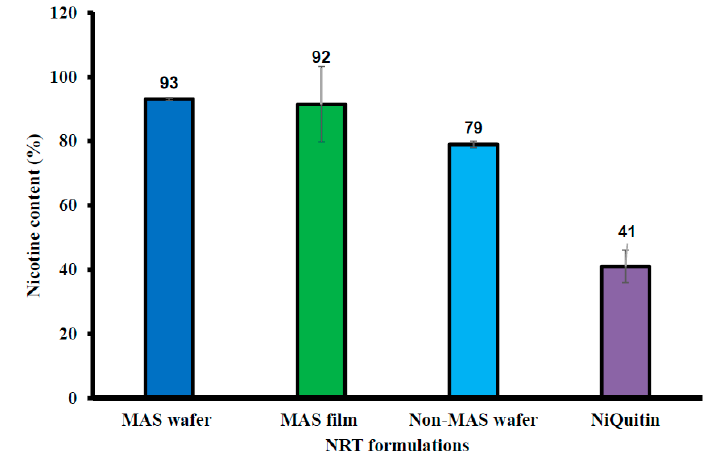
Figure 7. NIC content (%) in NiQuitin ® , HPMC–SA wafers and films ( n = 3, ± SD).